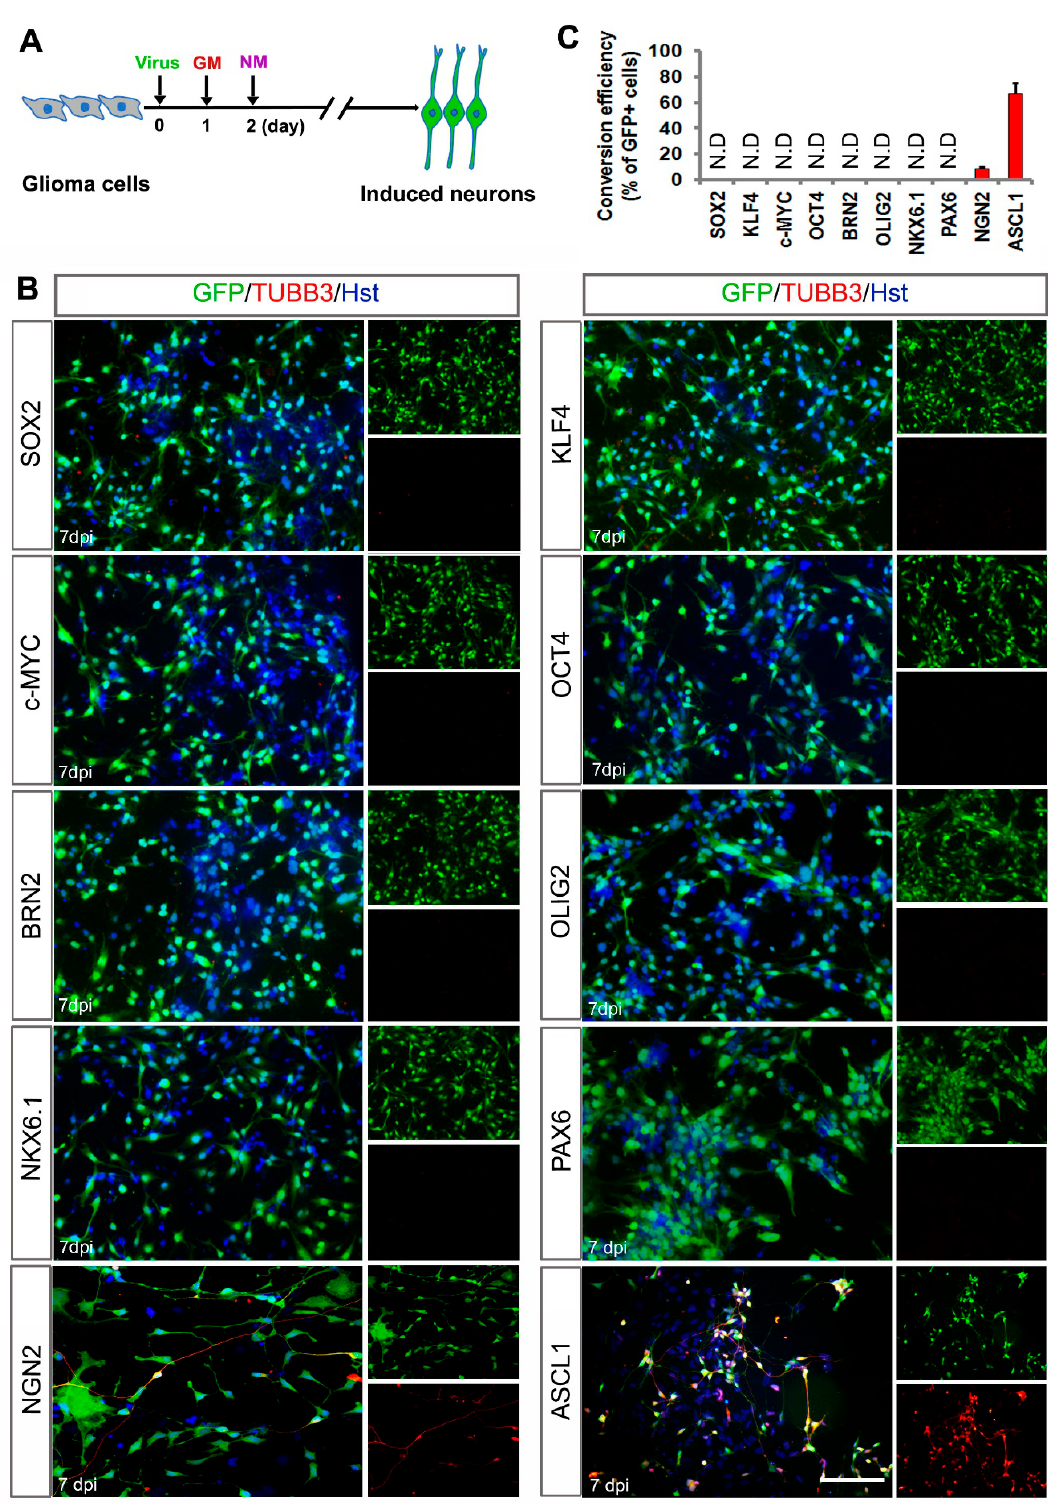
Figure 1. Identifying a single transcription factor to induce neuronal fate on human glioma cells. ( A ) Experimental schemes of transcription factor-mediated neuronal reprogramming. GM, growth medium; NM, neuronal induction medium. ( B ) Immunocytochemical analysis of tubulin beta-3 (TUBB3)-positive neuron-like cells seven days post infection of U251 cells with virus expressing the indicated transcription factors. Virus-transduced cells are indicated by the co-expressed GFP marker. ( C ) Quantification of U251 cell-converted TUBB3+ neuron-like cells. Conversion efficiency was normalized to GFP-positive cells. N.D, not detected. Scales = 100 μ m.